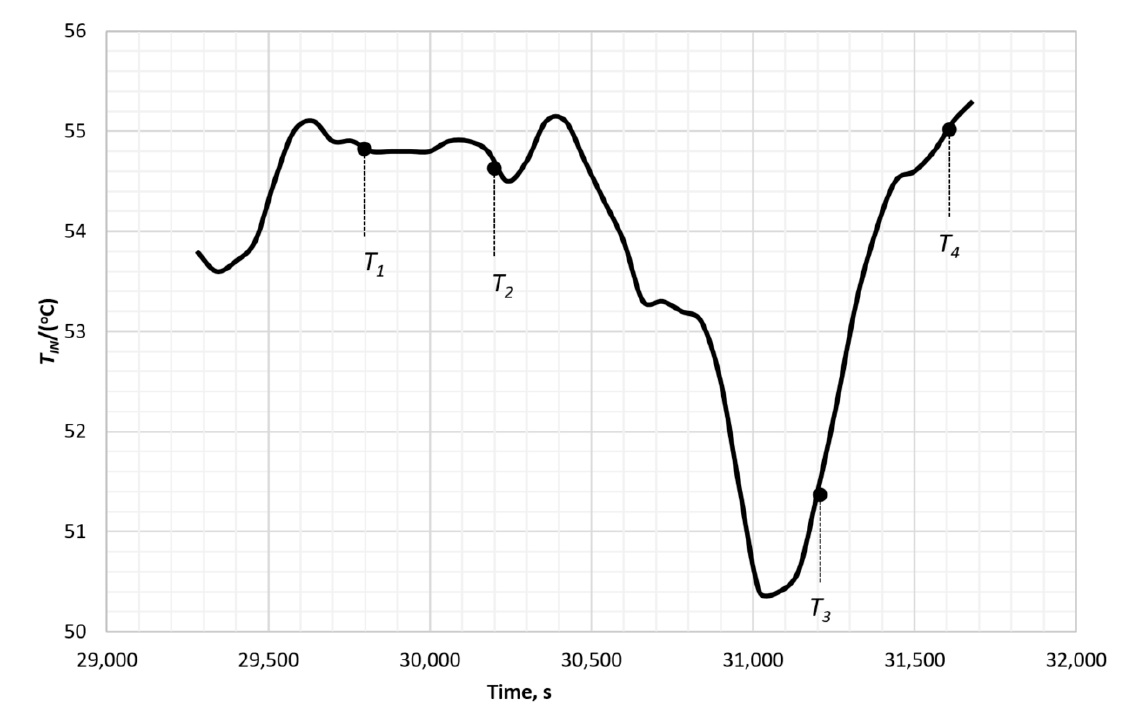
Figure 15. Fragment of temperature changes selected for analysis at the inlet of return pipe in the flat-collector loop.